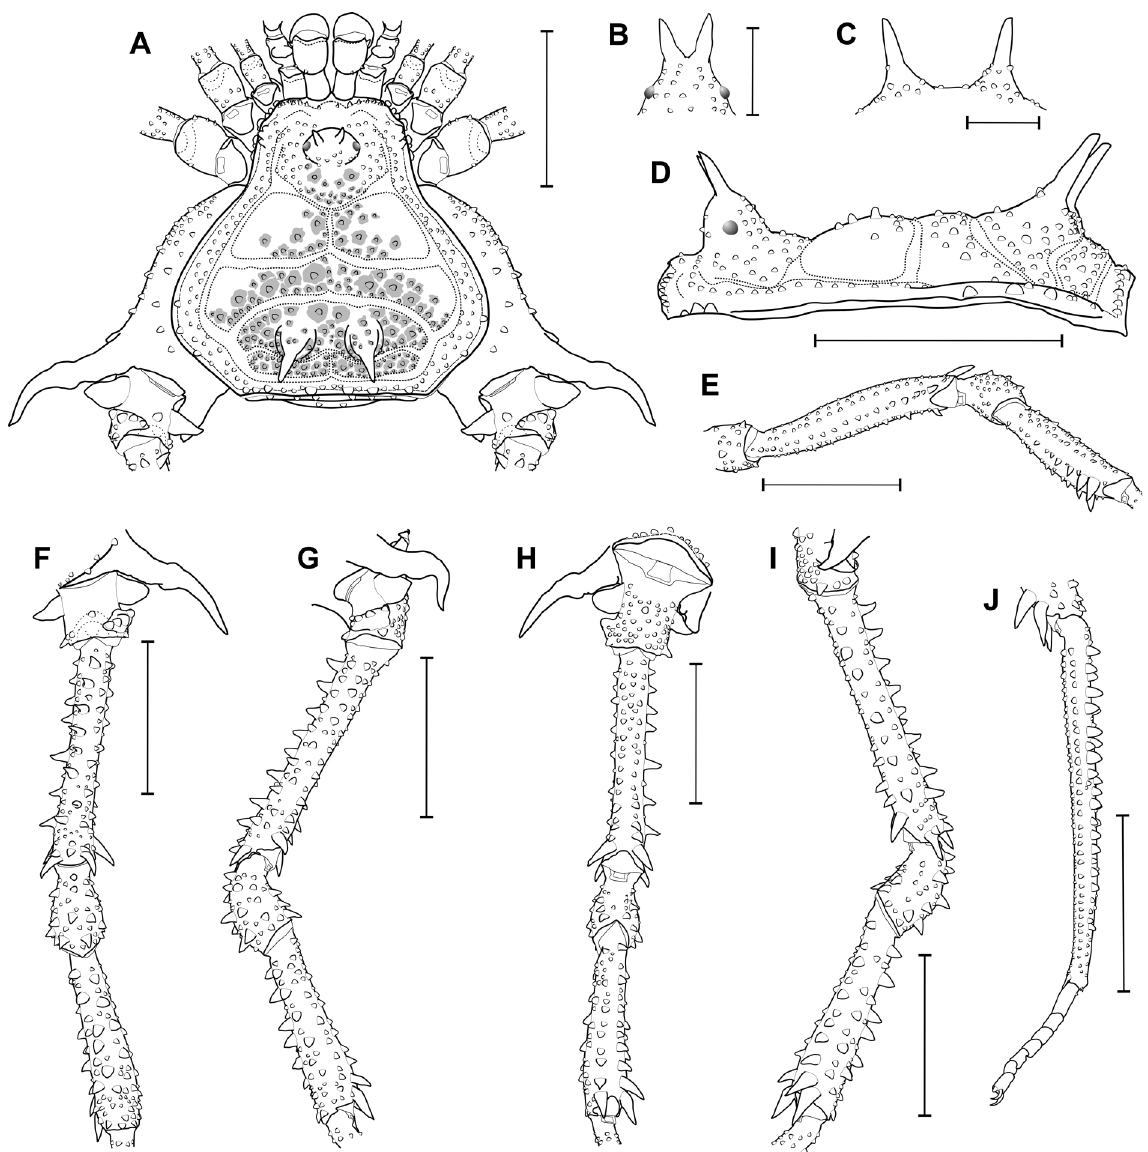
Fig. 19. Lacronia tenuis (Roewer, 1917) comb. nov., ♂ (MNRJ 260). A . Habitus, dorsal view. B . Ocularium, frontal view. C . Armature of mesotergum area III, posterior view. D . Habitus, lateral view. E . Left Fe–Ti III, proventral view. F . Right Fe–Ti IV, dorsal view. G . Same, prolateral view. H . Same, ventral view. I . Same, retro-lateral view. J . Right Mt–Ta IV, retro-lateral view. Scale bars: A, D–J = 3 mm; B–C = 1